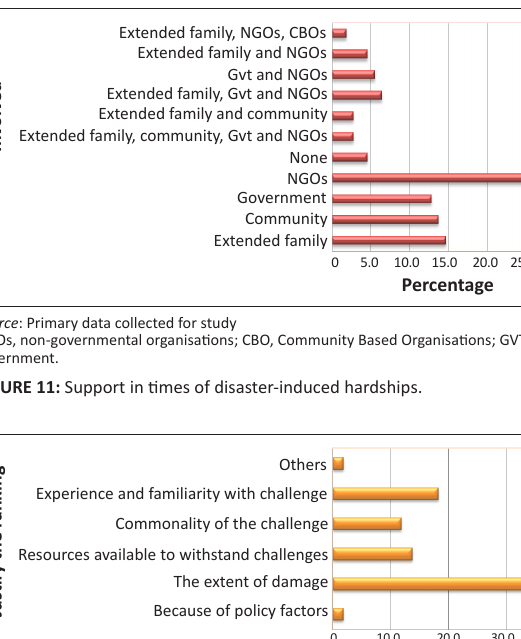
FIGURE 10: Who should be involved in disaster issues?